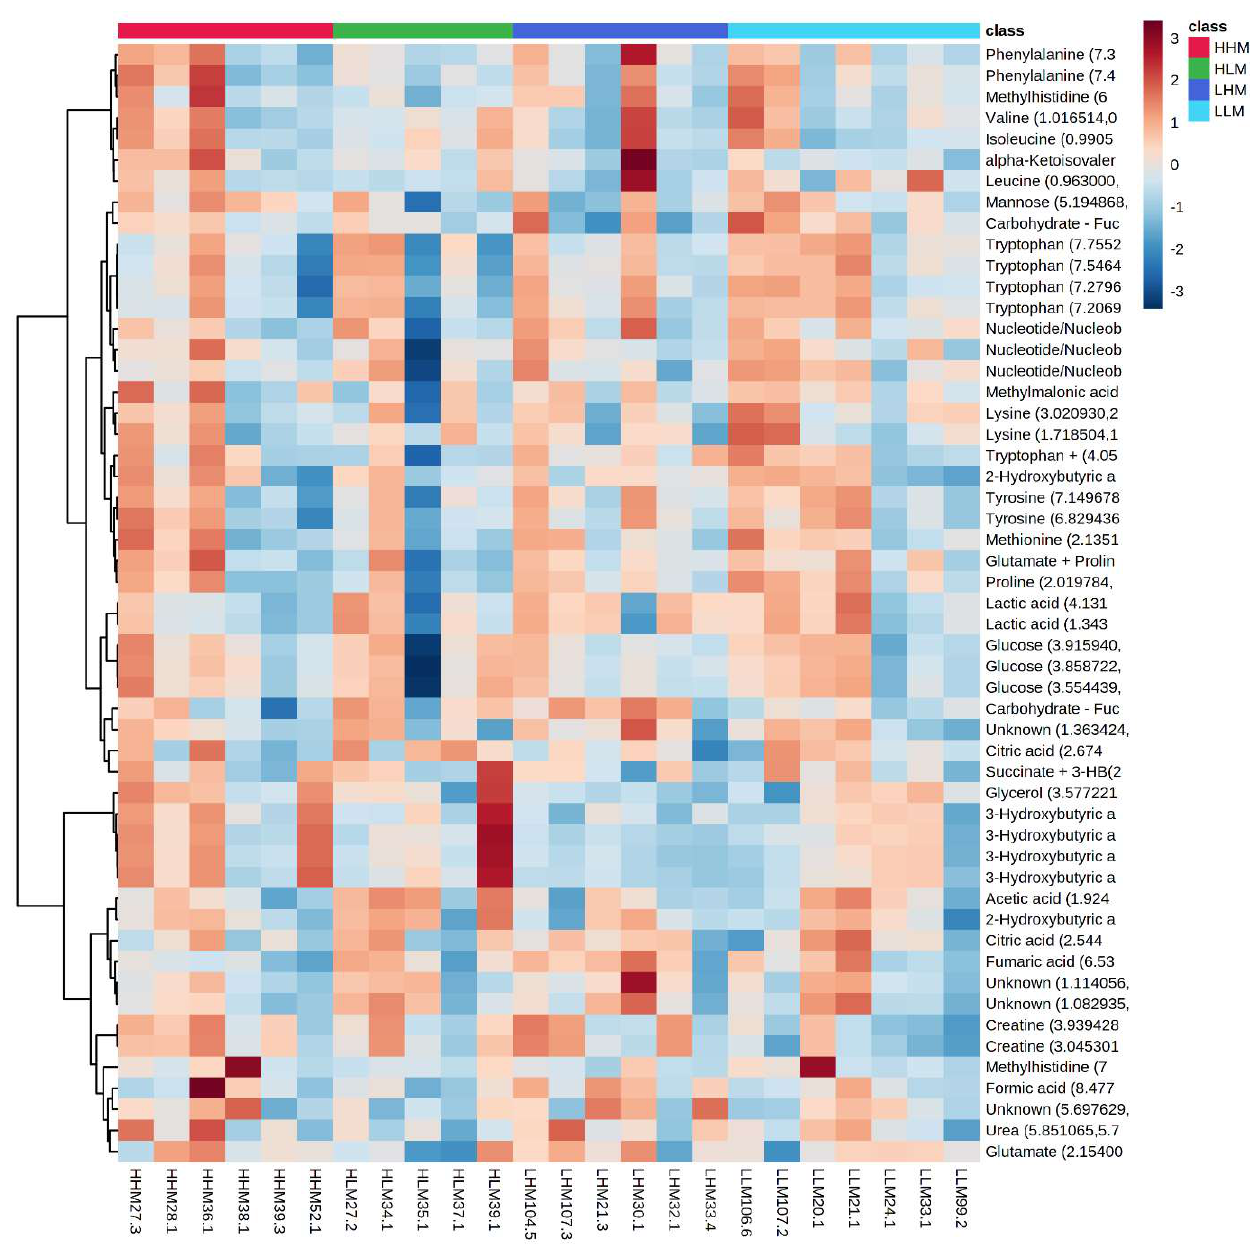
Figure 1. Heatmaps and dendrograms of metabolites in offspring exposed to high maternal and high postnatal LA diets in males (HHM: red), high maternal and low postnatal LA diets in males (HLM: green), low maternal and high postnatal LA diet in males (LHM: dark blue), and low maternal and low postnatal LA diet in males (LLM: light blue). All metabolites have been logarithmically scaled. Heatmap scales are denoted by red being higher concentrations, blue being lower, with white residing in the middle. Pearson clustering algorithm used for dendrograms to indicate relationships between metabolites in the cohort.